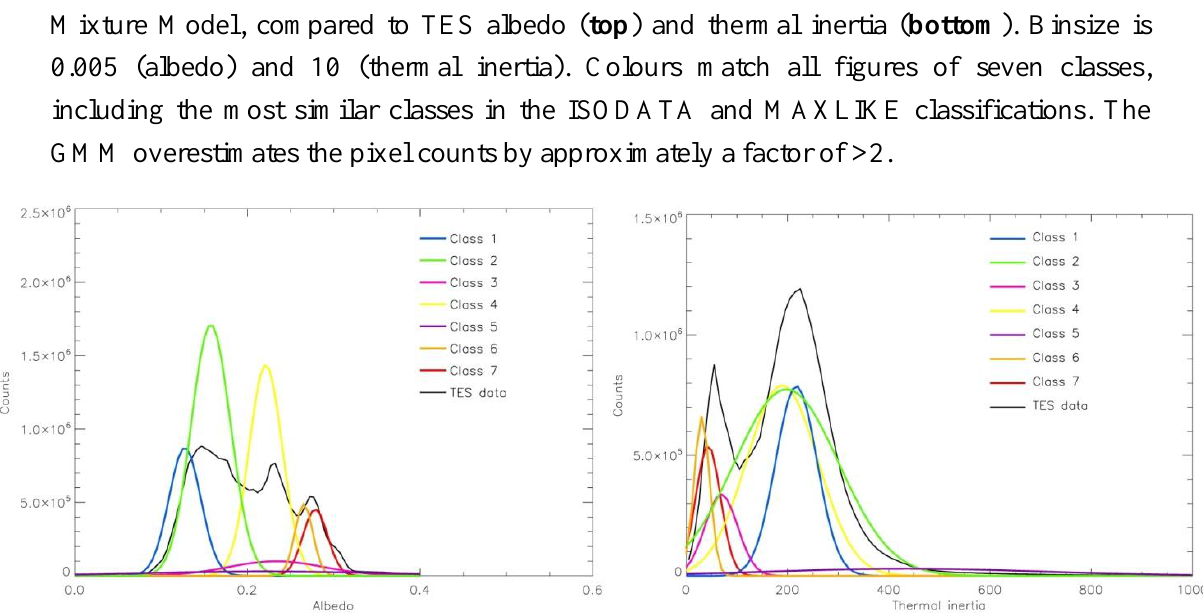
Figure 5. Histograms of classes produced by the Expectation Maximisation of a Gaussian Mixture Model, compared to TES albedo ( top ) and thermal inertia ( bottom ). Binsize is 0.005 (albedo) and 10 (thermal inertia). Colours match all figures of seven